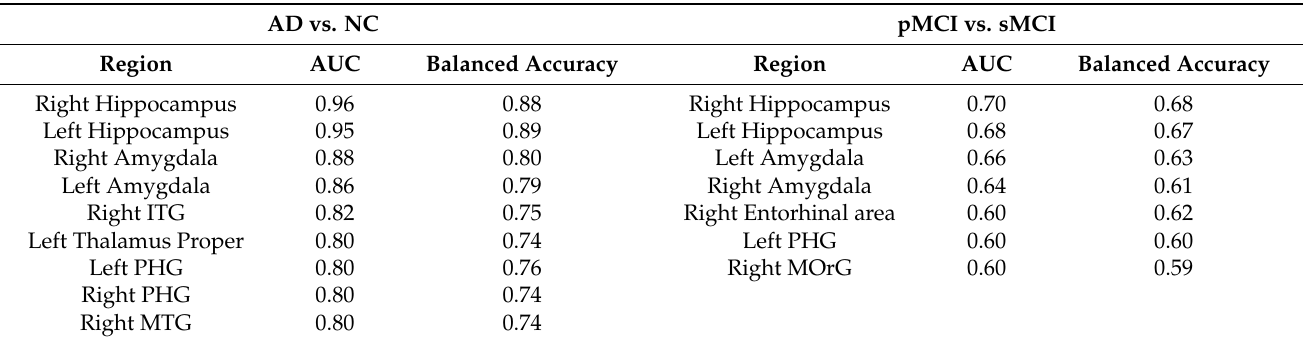
Table 2. The area showed the AUC value of 80 or more for NC vs. AD and an AUC value of 60 or more for sMCI vs.